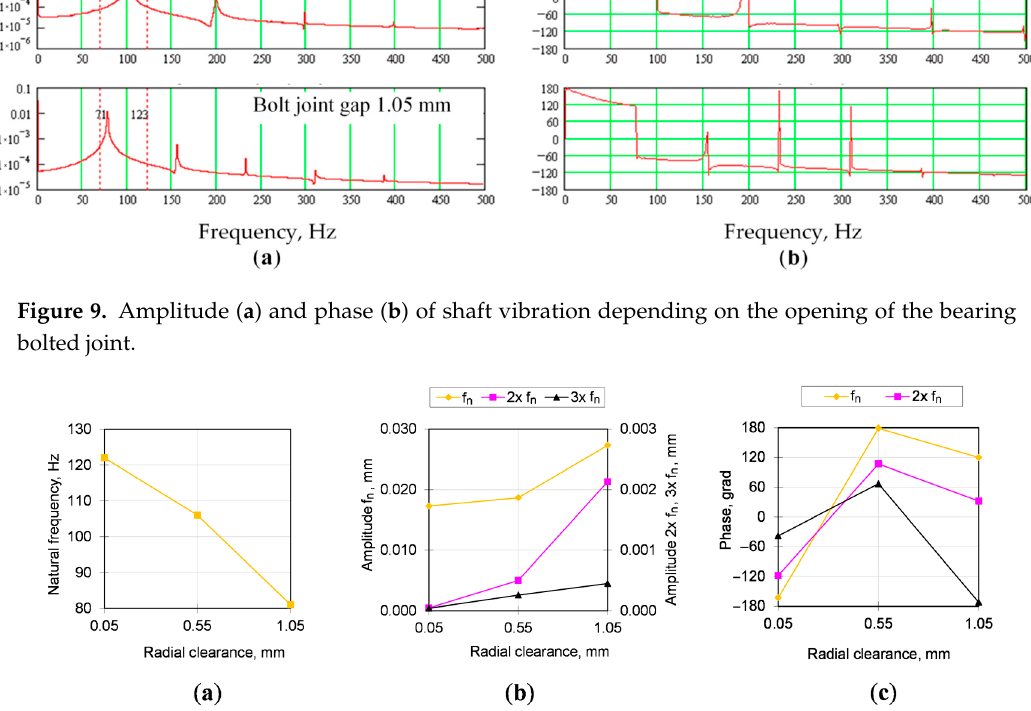
Figure 10. Natural frequency ( a ), amplitudes ( b ) and phases ( c ) of harmonics during transient vibrations of gearbox shaft with the wear of bolts (plastic elongation) and joint opening. Table 3. Results of vibration measurements (Figure 10).